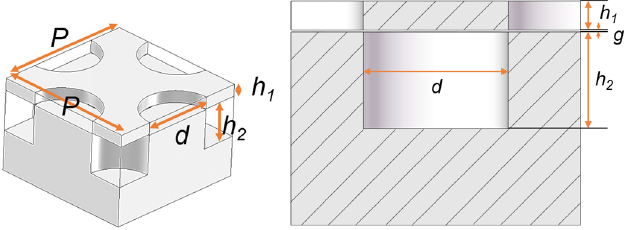
Figure 1. Configuration of the EBG rectangular waveguide line using glide-symmetric holes.